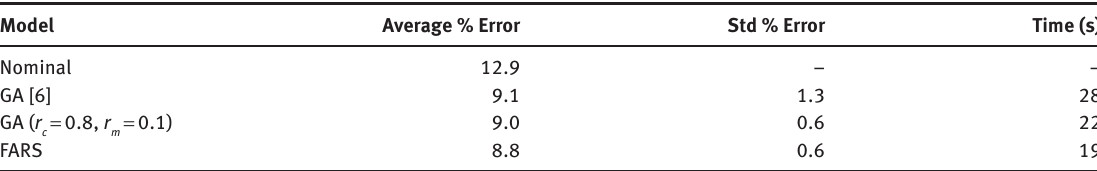
Table 6: Performance of Literature, Standard GA, and FARS Tuned Siciliano Models [Eq. (9)] in Terms of Percent Discrepancy between Actual and Predicted